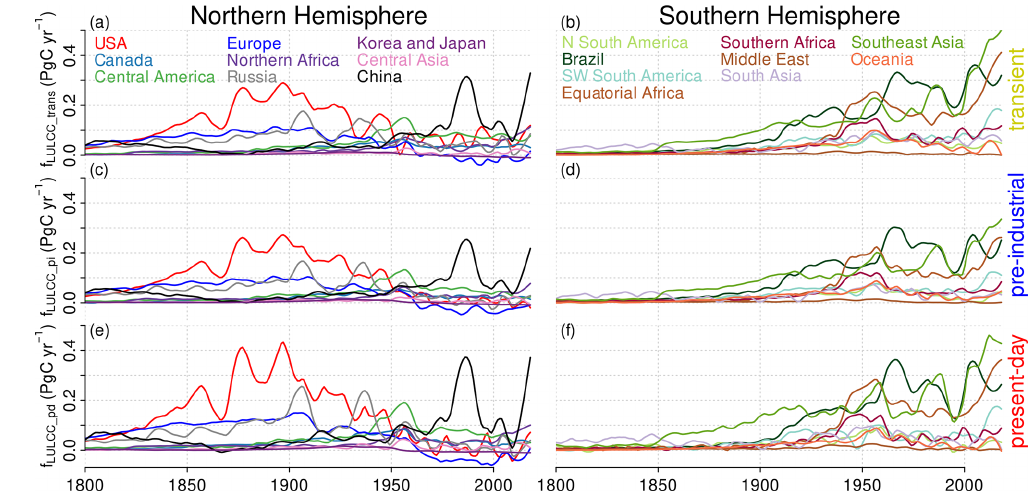
Figure 5. Region-wise smoothed multi-model mean annual f LULCC_trans (a, b) , f LULCC_pi (c, d) , and f LULCC_pd (e, f) from 1800 to 2018, derived according to Eqs. (1) to (3). For discussion of individual models refer to Sect. A1 and Figs. A7 to A9. f LULCC_pd was not derived for CLM5.0, JULES, LPJ, and OCN (Table 2).